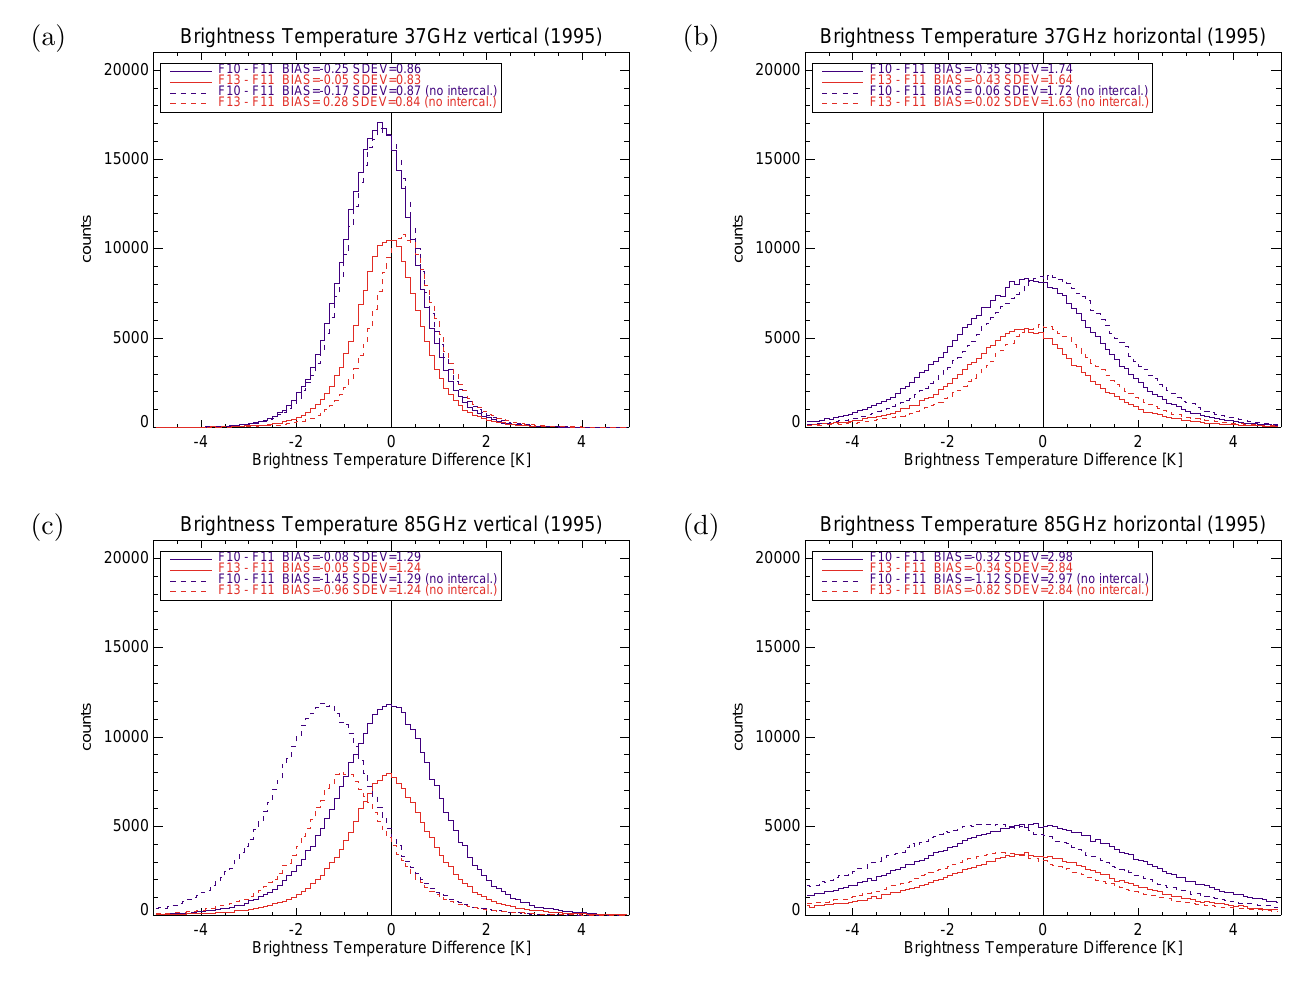
Figure 4. Same as Fig. 3, but for TB 37v (a) , TB 37h (b) , TB 85v (c) , and TB 85h (d) .